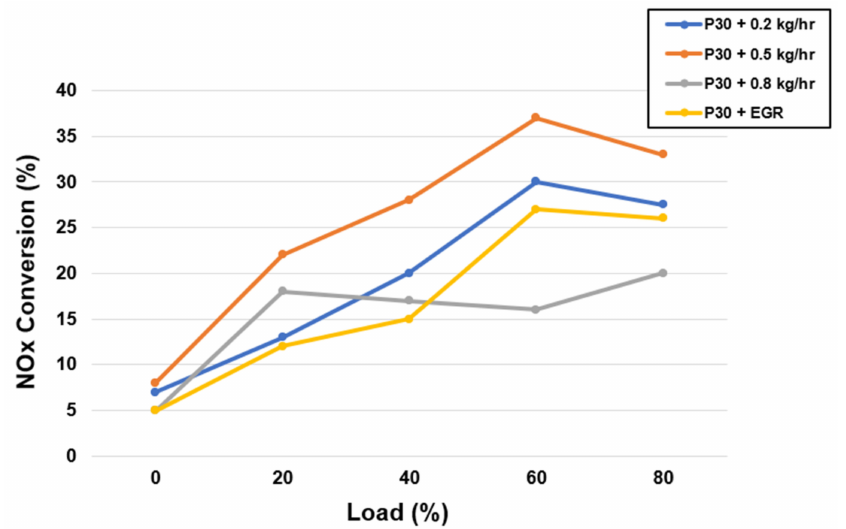
Figure 4. The variation in deNOx efficiency as a function of load [54].